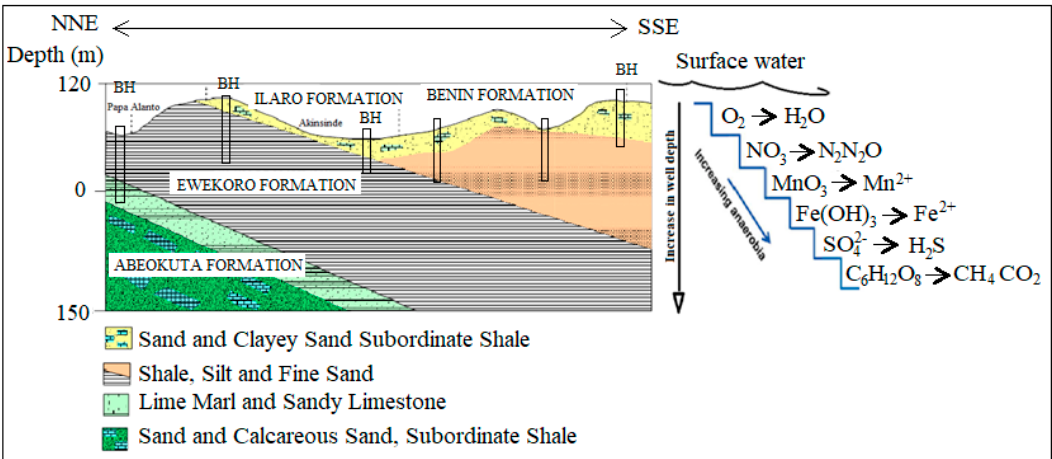
Figure 1. Schematic diagram of the biogeochemical process of some selected redox-sensitive ions in a typical coastal aquifer (Modified after [29]).